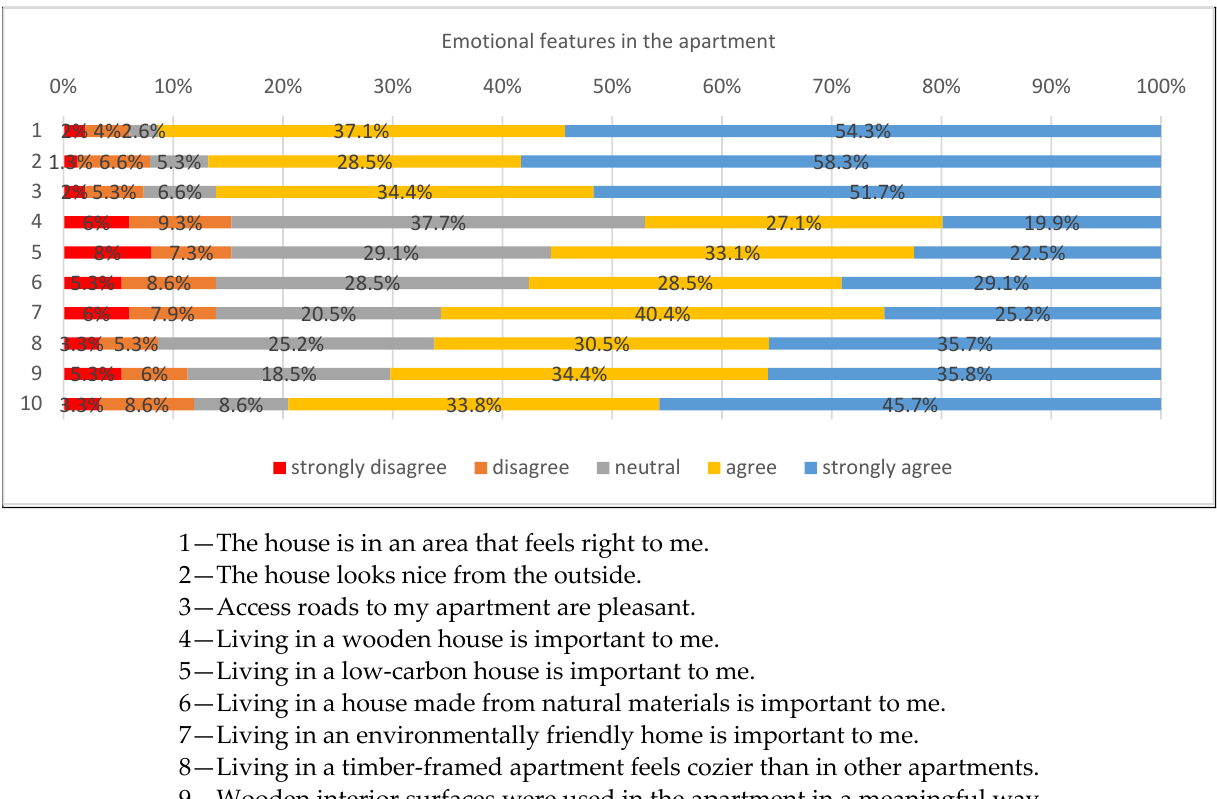
Figure 18. Emotional features of the apartment.